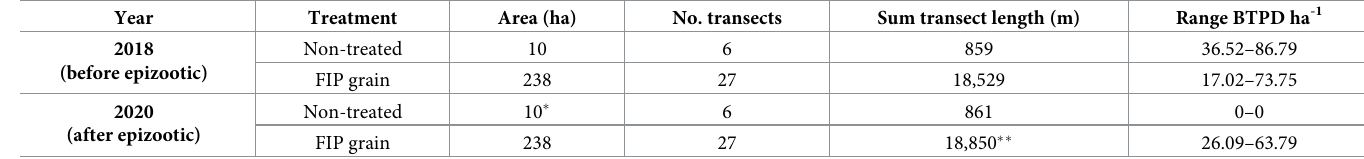
Table 1. Summary of active burrow transects and indexed black-tailed prairie dog (BTPD) densities in 2018 (before plague epizootic) and 2020 (after epizootic) on non-treated (baseline) and 0.005% fipronil (FIP) grain treated habitat, Rocky Mountain Arsenal National Wildlife Refuge, Colorado.